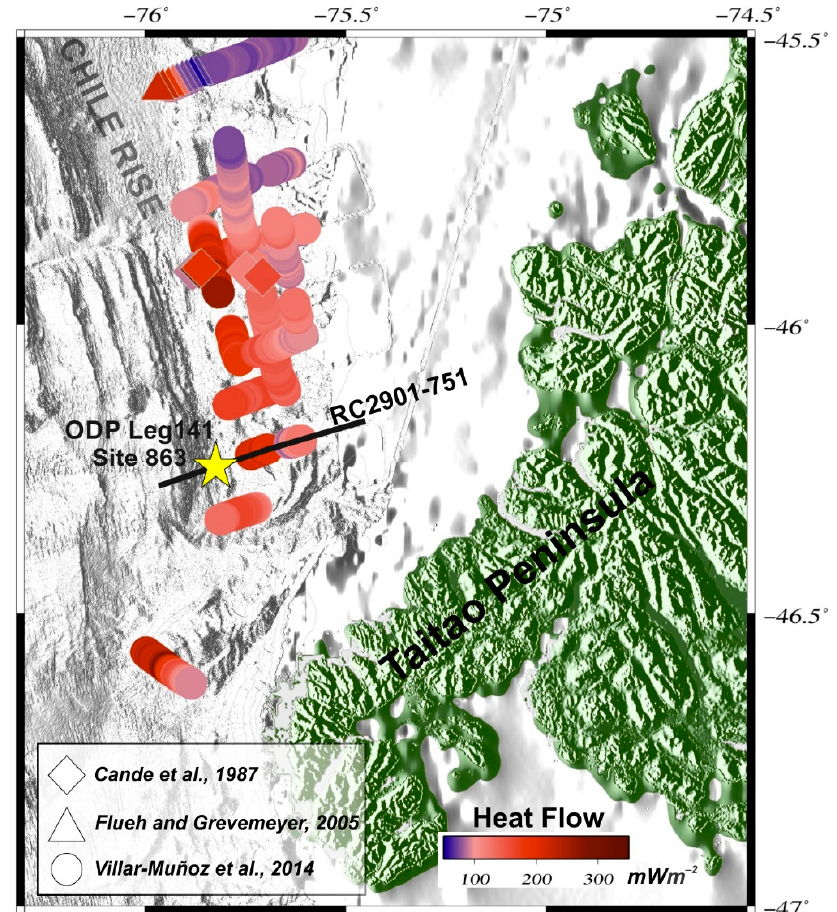
Figure 2. Heat flow (in m · Wm − 2 ) large-scale colour-coded based on BSR-derived heat flow and heat probes available for the area studied (after [26]). See text for description.